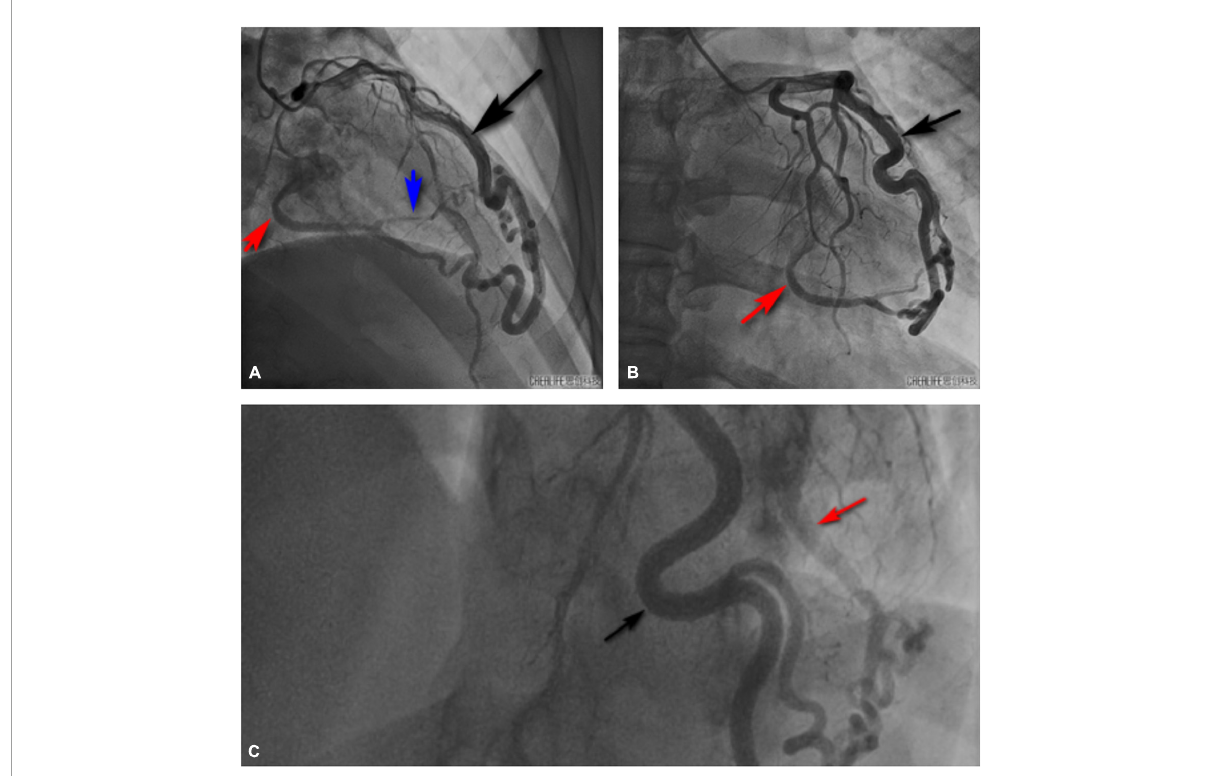
FIGURE5 Invasive coronary angiography also showed that the diagonal branch of the left coronary artery was twisted, lengthened, expanded, extended along the left heart margin, and its distal end penetrated the myocardium from the basal segment of the left ventricular posterior edge into the left ventricle. Black arrow shows the thick diagonal branch; red arrow shows the coronary artery-left ventricular fistula; blue arrow shows the branch of coronary artery fistula that supplies the left ventricular posterior wall myocardium. (A) Right cranial view. (B) Anteroposterior view. (C) Left cranial